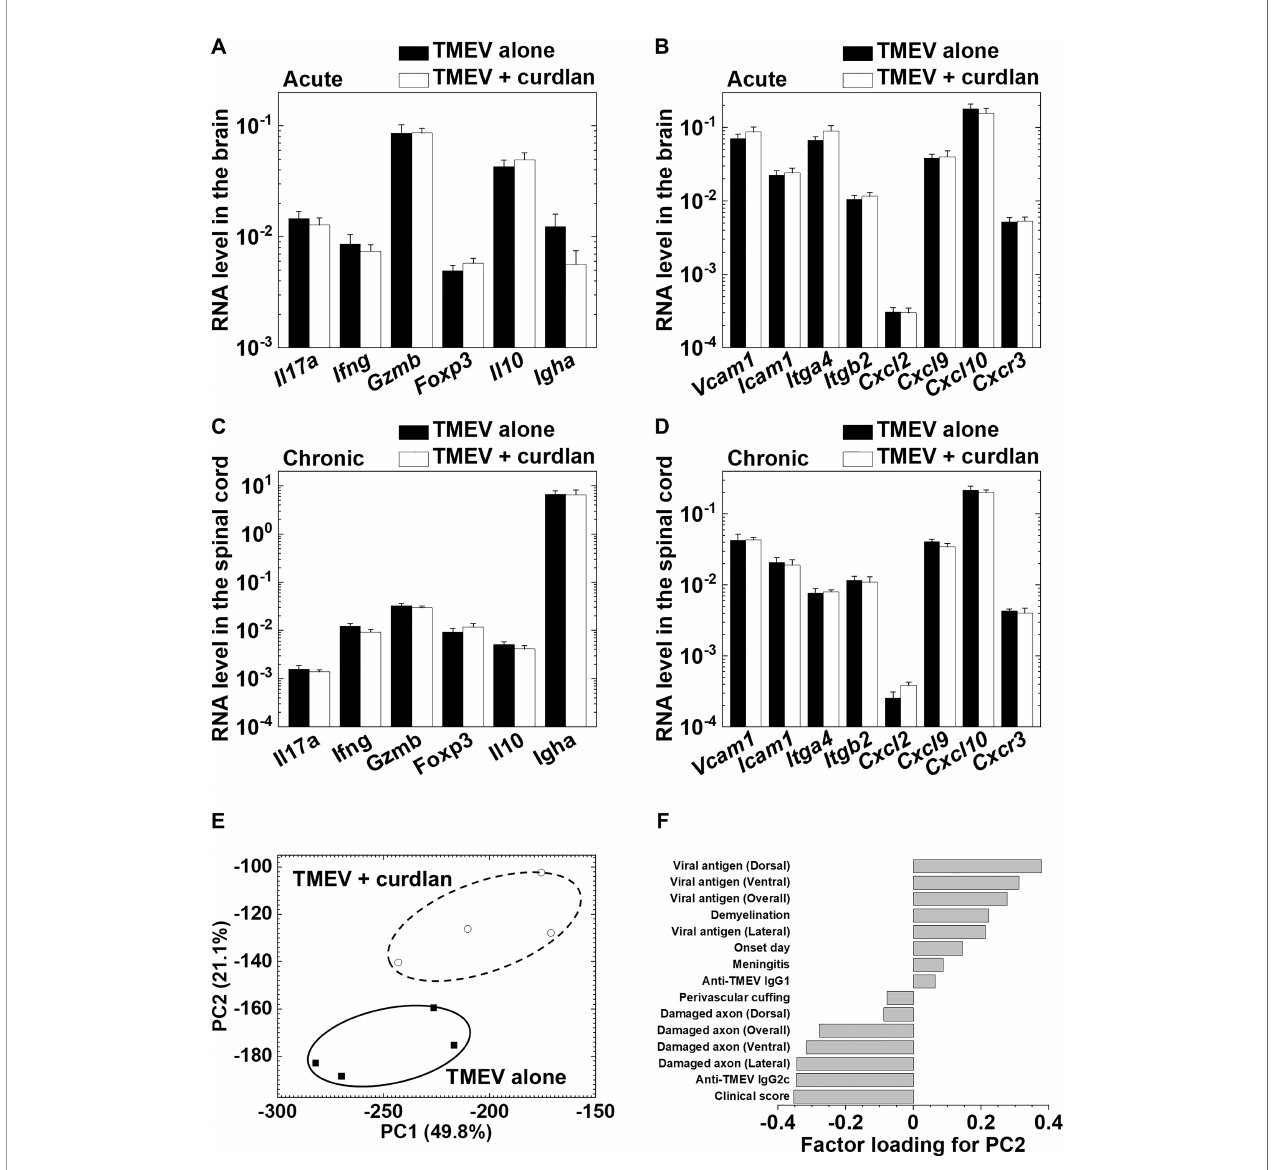
FIGURE 7 | Curdlan injection did not alter immune-related gene expressions in the central nervous system (CNS) during the acute and chronic phases of TMEV infection between the control and curdlan treatment groups. (A – D) Real-time PCR analyses of T cell-related and immune cell migration/in fi ltration-related genes in the brain 8 days p.i. (A, B) and in the spinal cord 5 weeks p.i. (C, D) . (A, C) mRNA levels of Il17a , Ifng , Gzmb , Foxp3 , Il10 , and Igha . (B, D) mRNA levels of Vcam1 , Icam1 , Itga4 , Itgb2 , Cxcl2 , Cxcl9 , Cxcl0 , and Cxcr3 . Pgk1 expression was used as a housekeeping gene for normalization. Values are the mean + SEM of four mice per group. (E) Principal component analysis (PCA) separated TMEV-infected control and curdlan-treated mice as two distinct populations by the principal component (PC) 2 values. We conducted PCA, using 15 immunopathology data: neuropathology (demyelination, perivascular cuf fi ng, meningitis, viral-antigen positive cells, damaged axons), antibody titers, clinical scores, and the disease onset day from the two groups 5 weeks p.i. Each group was composed of four mice. (F) Factor loading for PC2 showed that clinical scores and damaged axon numbers contributed to the PC2